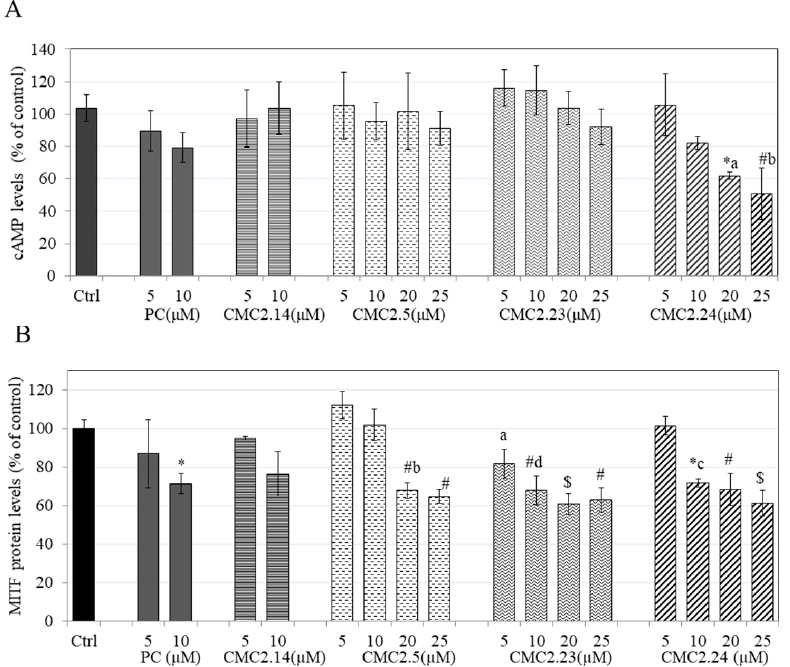
Figure 9. ( A ) cAMP levels estimated by ELISA in cultures of B16F10 cells treated for 48 h with different concentrations of PC and CMCs, * p < 0.05 and # p < 0.01 vs. control; letter a— p < 0.05